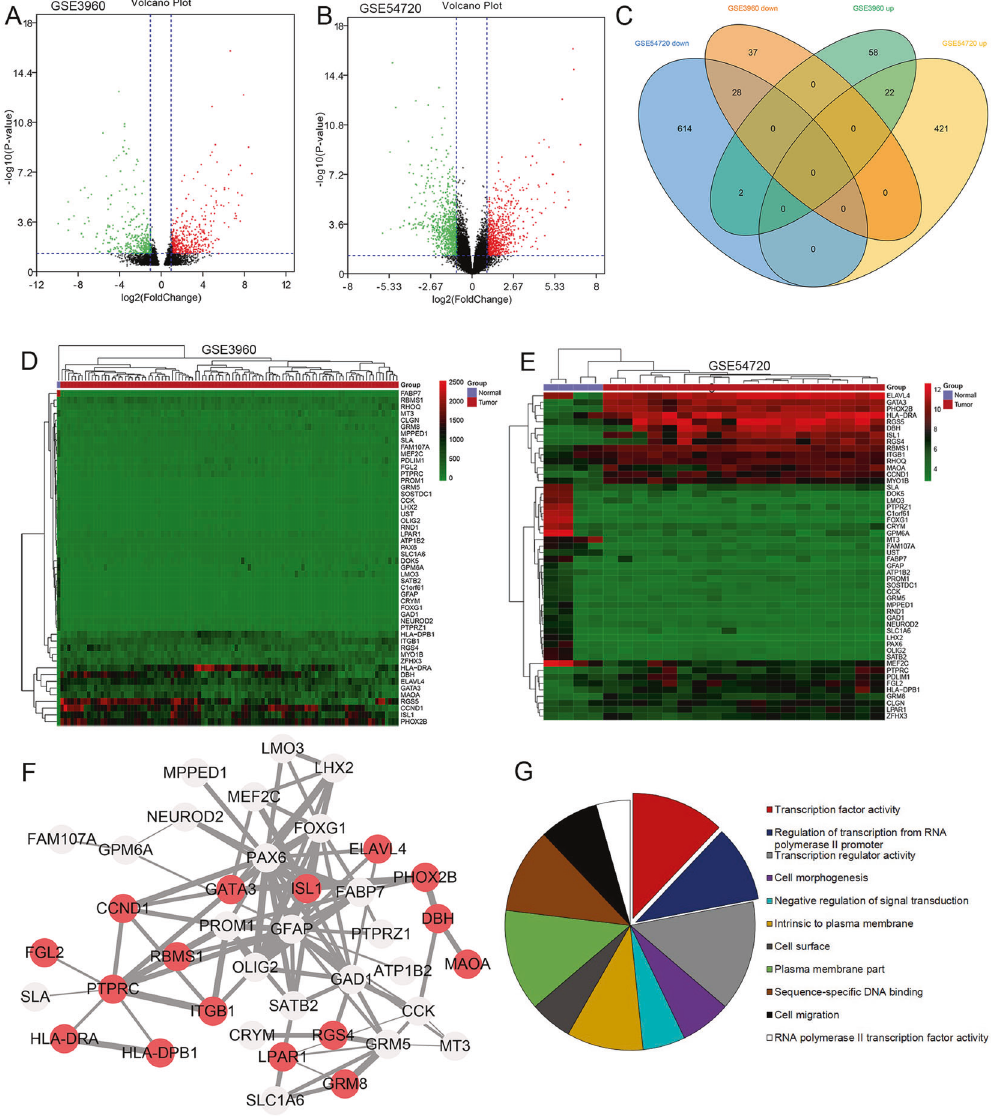
Fig. 1 Bioinformatics analysis identi fi ed overlapped DEGs between GSE3960 and GSE54720 and performed functional enrichment. A , B Volcano plots of GSE3960 and GSE54720, where red dots, green dots, and black dots indicate upregulated, downregulated, and not differentially expressed genes, respectively. C Venn diagram shows 22 upregulated and 28 downregulated genes. D , E Heatmaps of common DEGs between NB and normal controls in GSE3960 and GSE54720. F PPI network of overlapping DEGs at the protein level. G GO analysis reveals 50 overlapping DEGs are mostly enriched in transcription factor activity ( P = 1.06 × 10 − 3 ) and regulation of transcription from RNA polymerase II promoter ( P = 1.55 × 10 − 3 ). n = 50 genes, 41 Gene Ontology classi fi